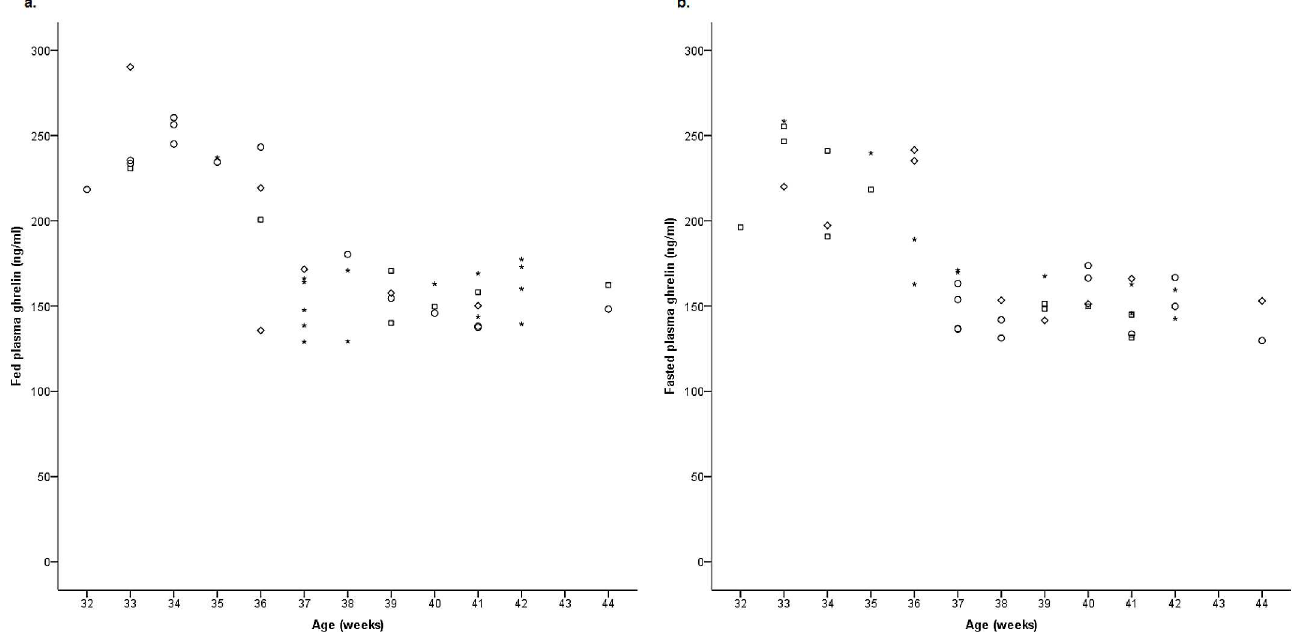
Fig 3. Correlation of plasma ghrelin concentrations with rat age. Plasma ghrelinconcentrations negativelycorrelated with age (fed, r = -0.715, P < 0.001,n = 42) (fasted, r = -0.744, P < 0.001,n = 43). ( (cid:14) proestrus; □ oestrus; ^ metoestrus; *